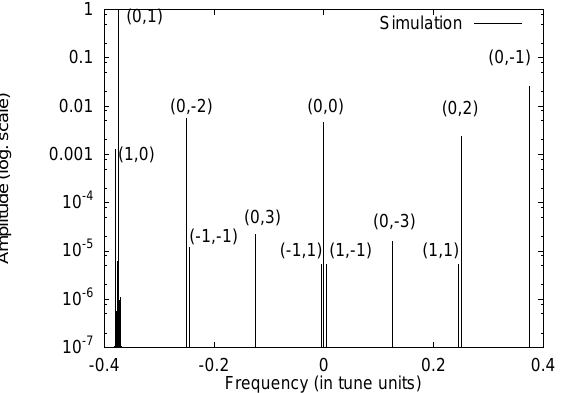
FIG. 1. Normalized Fourier spectrum of the horizontal motion of a particle. The label (cid:1) m , n (cid:2) attached to each line indicates that the frequency of that line is mQ x 1 nQ D . For example, the line (cid:1) 0, 2 (cid:2) is mainly due to the term h 1200 .